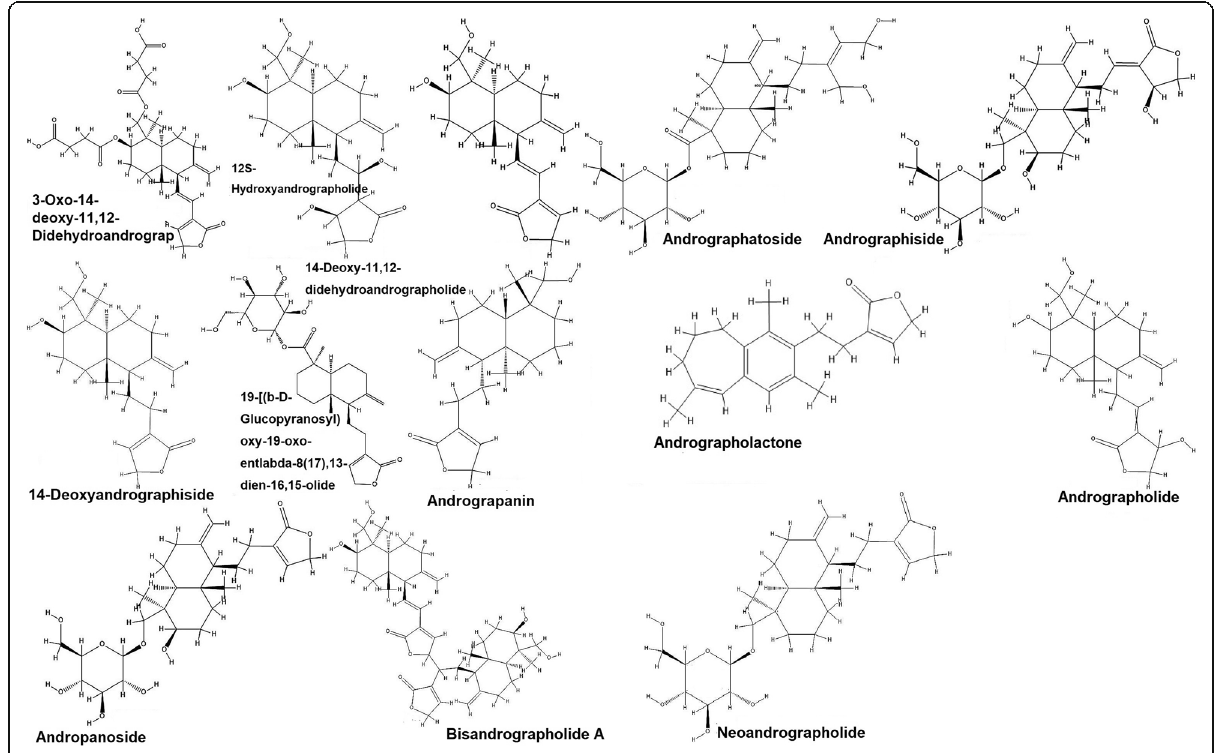
Fig. 6 Structure of diterpenoids identified by